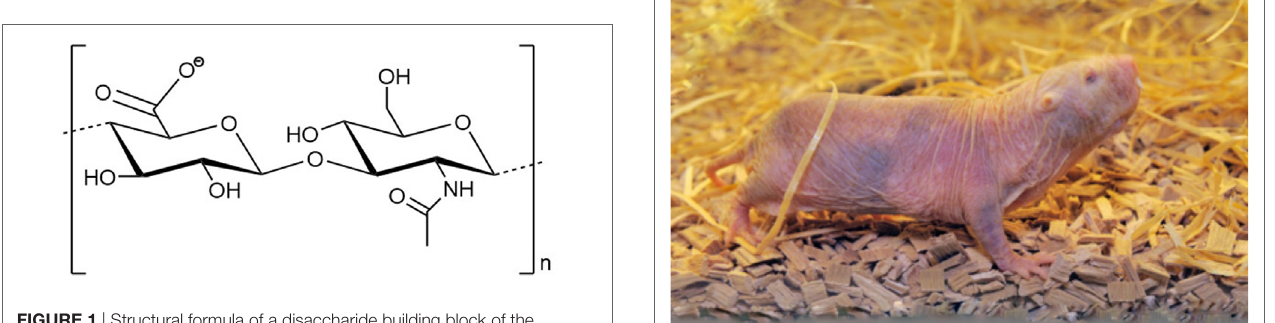
FiGURe 2 | Naked mole rat in captivity ( © Tiergarten Schoenbrunn, Austria/ Norbert Potensky).